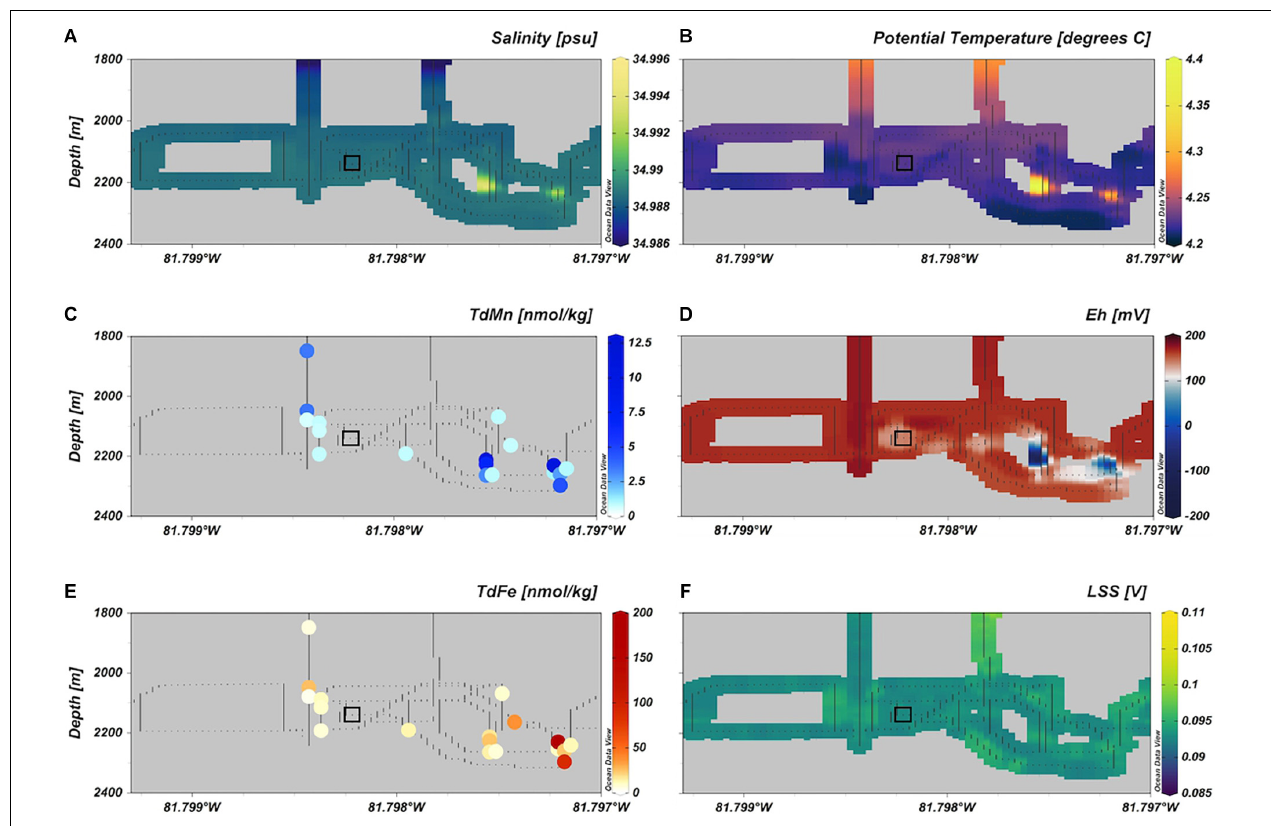
FIGURE 2 | The detection of hydrothermal plume anomalies in the water column over the VDVF for (A) salinity, (B) potential temperature, (C) TDMn, (D) Eh, (E) TDFe, and (F) LSS. The square box shows the location of SAPS deployment. Plots were created using Ocean Data View (Schlitzer,